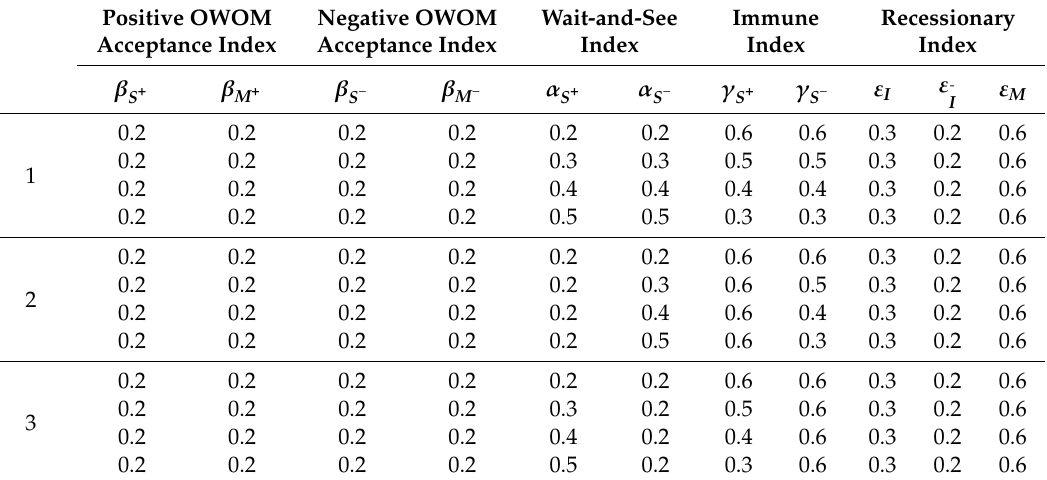
Table 6. Simulation Experiment 3 parameter setting.